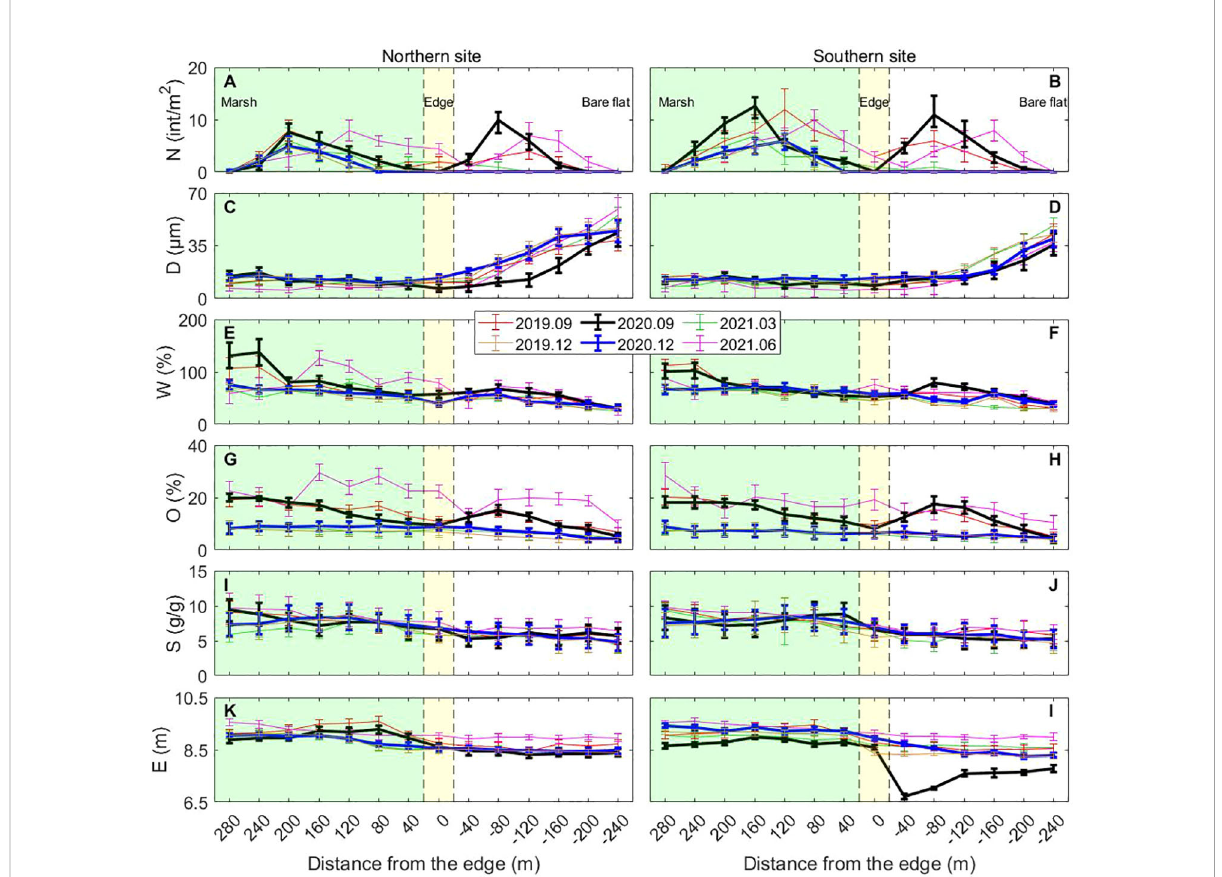
FIGURE 3 The spatial distribution of crab burrow and environmental variables across the shore in different seasons. (A) The density of crab burrows in northern site; (B) The density of crab burrows in southern site; (C) The median grain size in northern site; (D) The median grain size in southern site; (E) The water content in northern site; (F) The water content in southern site; (G) The organic content in northern site; (H) The organic content in southern site; (I) The soil salinity in northern site; (J) The soil salinity in southern site; (K) The elevation in northern site; (L) The elevation in southern site; Data is shown as means ± SE (n=15). The origin of coordinates means the edge of salt marshes. X-axis means the distance from the edge with positive values indicating seaward and negative representing landward. Point +20~+280m (the background color: green) are in the salt marsh. Point -20m~20m (the background color: yellow) are around the edge. Point -20m~-240m (the background color: white) are on the bare fl